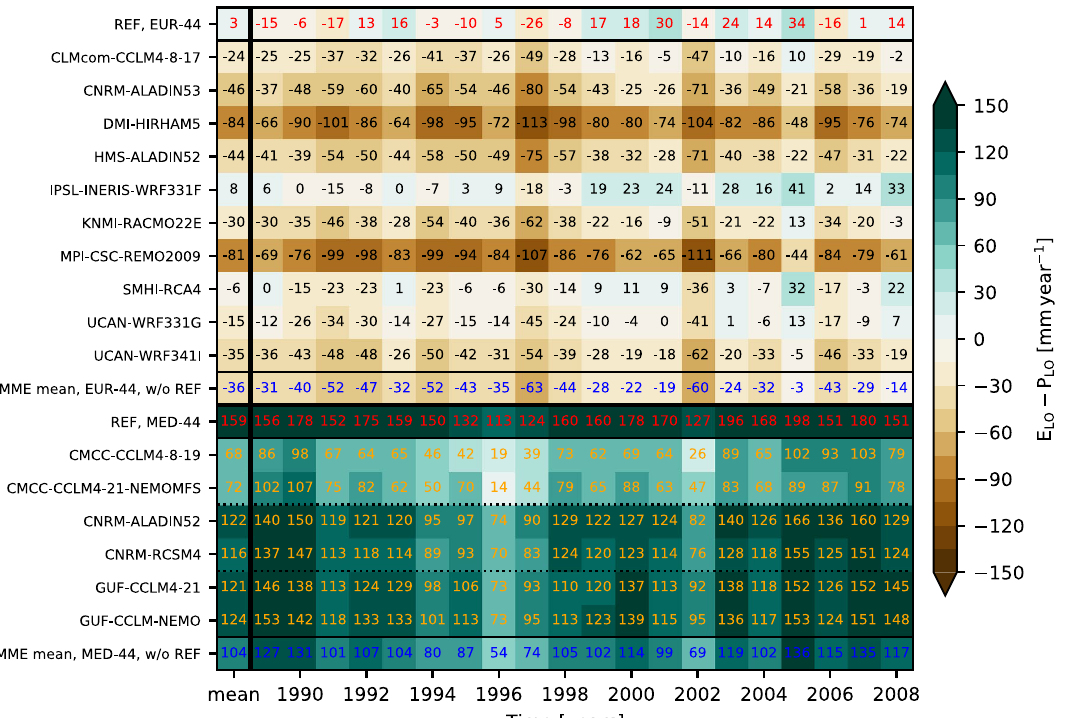
Figure 3. Atmospheric water budgets (div Q LO = E LO – P LO [mm year −1 ]) from 1989 to 2008 from domain- averaged annual P LO and E LO sums. Upper part: Pan-European domain (EUR-44); lower part: Mediterranean domain (MED-44), the stippled lines separate the different RCM/AORCM model pairs. First row of each part: REF (red numbers); subsequent rows below: each RCM (black and yellow numbers); last row of each part: multi-model mean (blue numbers). The leftmost column shows the 20-year div Q LO averages of REF and each RCM. The REF data are remapped to the 0.44° grid. The 20-year spatial averages for REF are